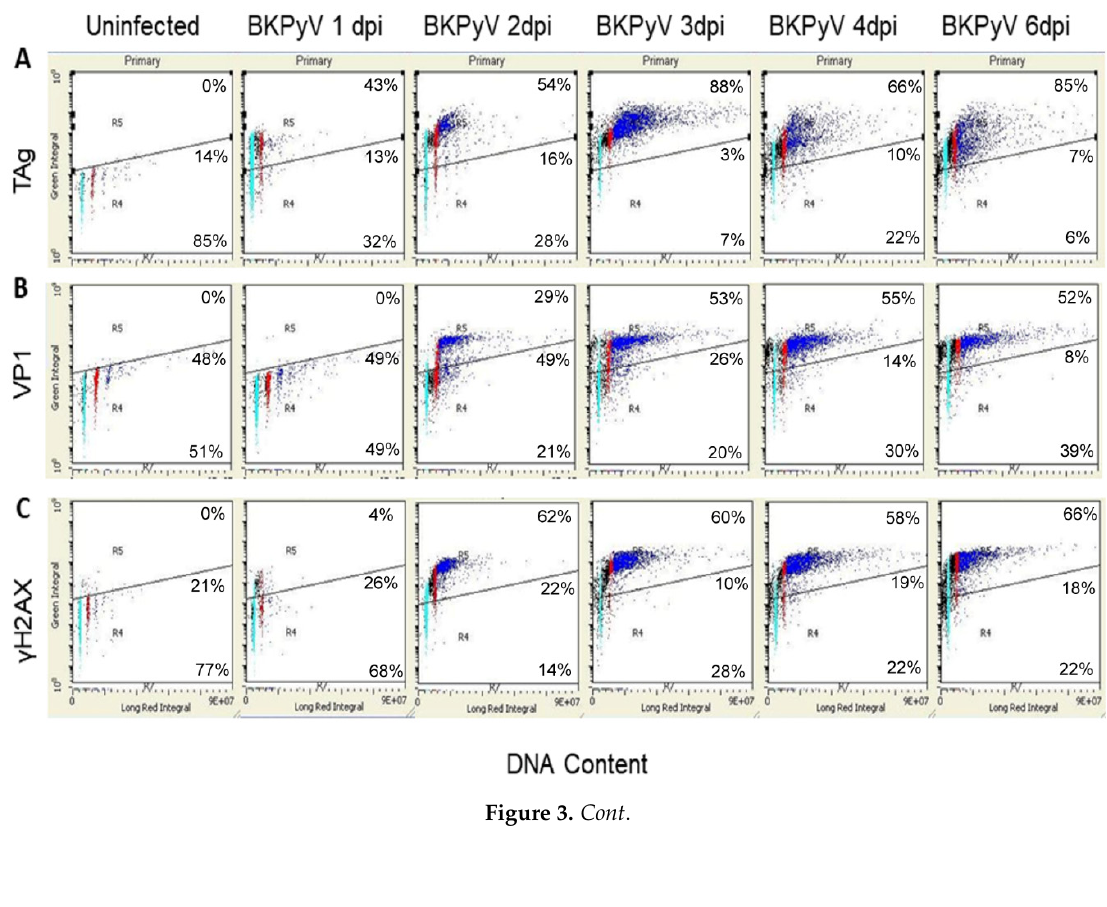
Figure 2. Dual immunofluorescent detection of a DNA damage response in virus-infected cells in PyVAN. Formalin-fixed paraffin-embedded PyVAN biopsy (stage B2). ( A ) Polyomavirus-infected tubular epithelial cells visualized by immuno- fluorescent staining for TAg (PAb416 and Alexa488 goat anti-mouse IgG). ( B ) Intranuclear γ H2AX in tubular epithelial cells (anti pH2AX-Ser139 and Alexa594 goat anti-rabbit IgG). ( C ) Merge of images in A and B. Open arrowhead indicates a TAg-positive, γ H2AX-negative tubular epithelial cell; filled arrowheads indicate TAg-positive, γ H2AX-positive cells with nuclear inclusions. (60× objective).